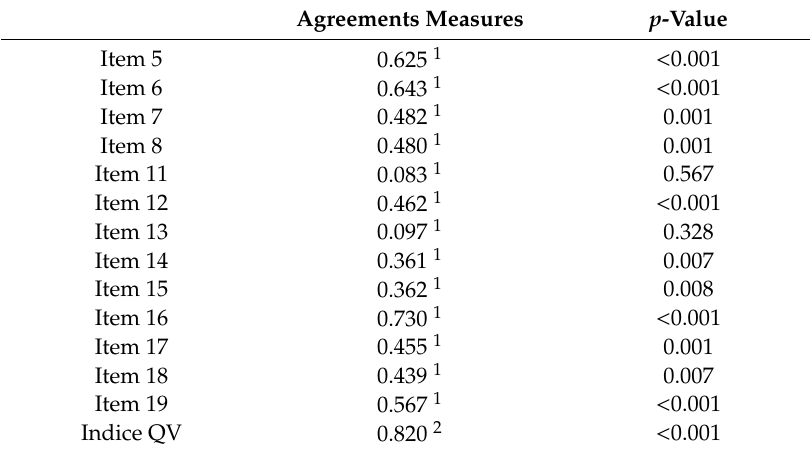
Table 2. VEGQOL reproducibility